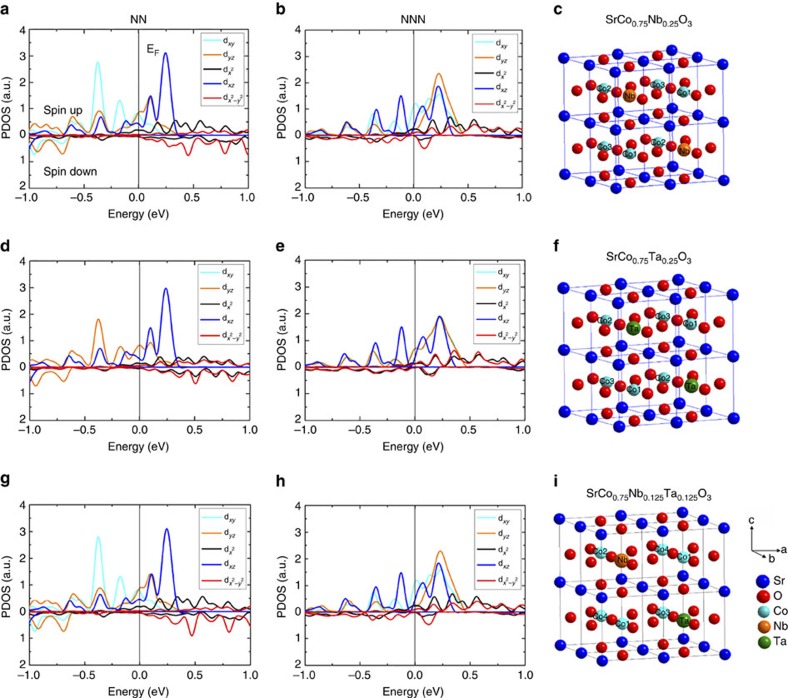
Density of states of the neighbouring Co atoms to the dopants in single-doped and co-doped models.Atomic-orbital-resolved electron density of states (PDOS) projected onto the nearest neighbouring (NN) Co atoms (left column) and the next nearest neighbour (NNN) Co atoms (middle column) of (a,b) SrCo0.75Nb0.25O3−δ, (d,e) SrCo0.75Ta0.25O3−δ and (g,h) SrCo0.75Nb0.125Ta0.125O3−δ perovskite oxides, and the corresponding schematic of unit cells (right column). The energy at the Fermi level is set to zero. (c,f,i) A schematic of the corresponding single and co-doped models for the first-principles calculations.